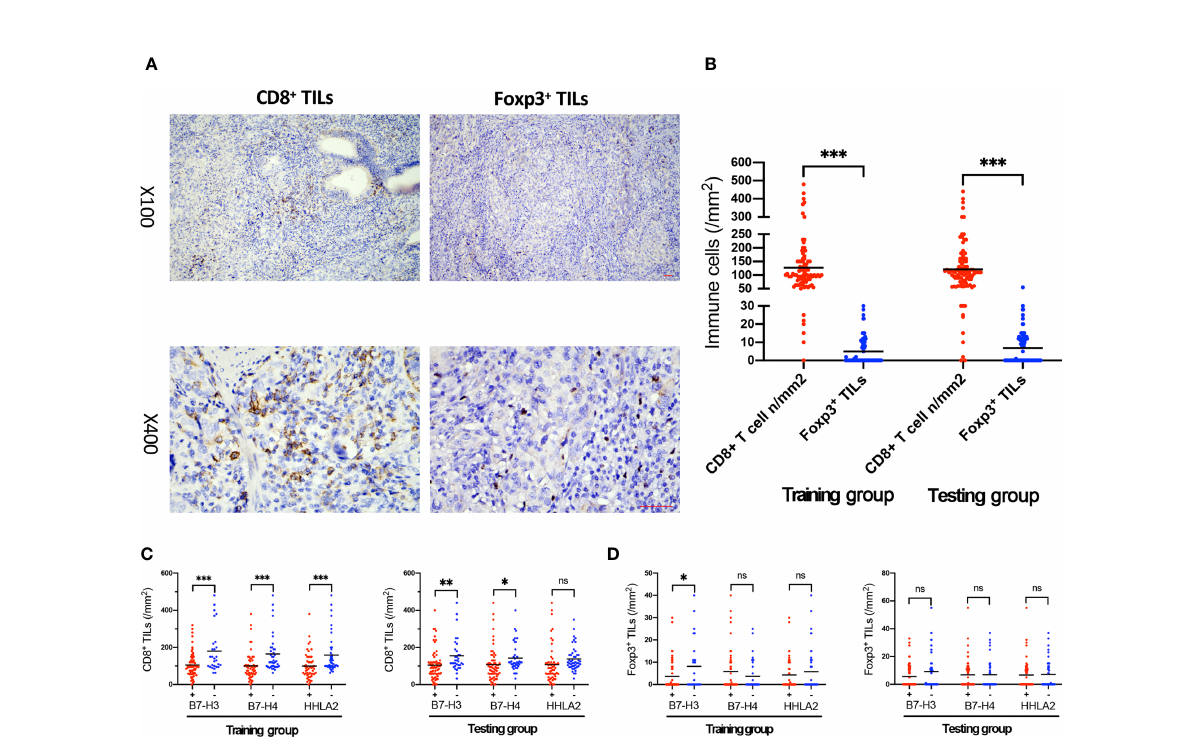
FIGURE 3 The association of B7-H3, B7-H4, and HHLA2 expression with the density of TILs. (A) Immunohistochemical staining of CD8 and Foxp3 expression within tumor tissue; scale bar, 50 m m. (B) Scatter plot presenting the density of CD8+ and Foxp3+ TILs in the training and testing groups. (C) The density of CD8+ TILs in tumors associated with B7-H3, B7-H4, and HHLA2 expression (+, high expression; -, low expression) in the training and testing groups. (D) The density of Foxp3+ TILs in tumors associated with B7-H3, B7-H4, and HHLA2 expression (+, high expression; -, low expression) in the training and testing groups. (Error bars indicate the mean, *p < 0.05, **p ≤ 0.01, ***p ≤ 0.001, ns, no signi fi